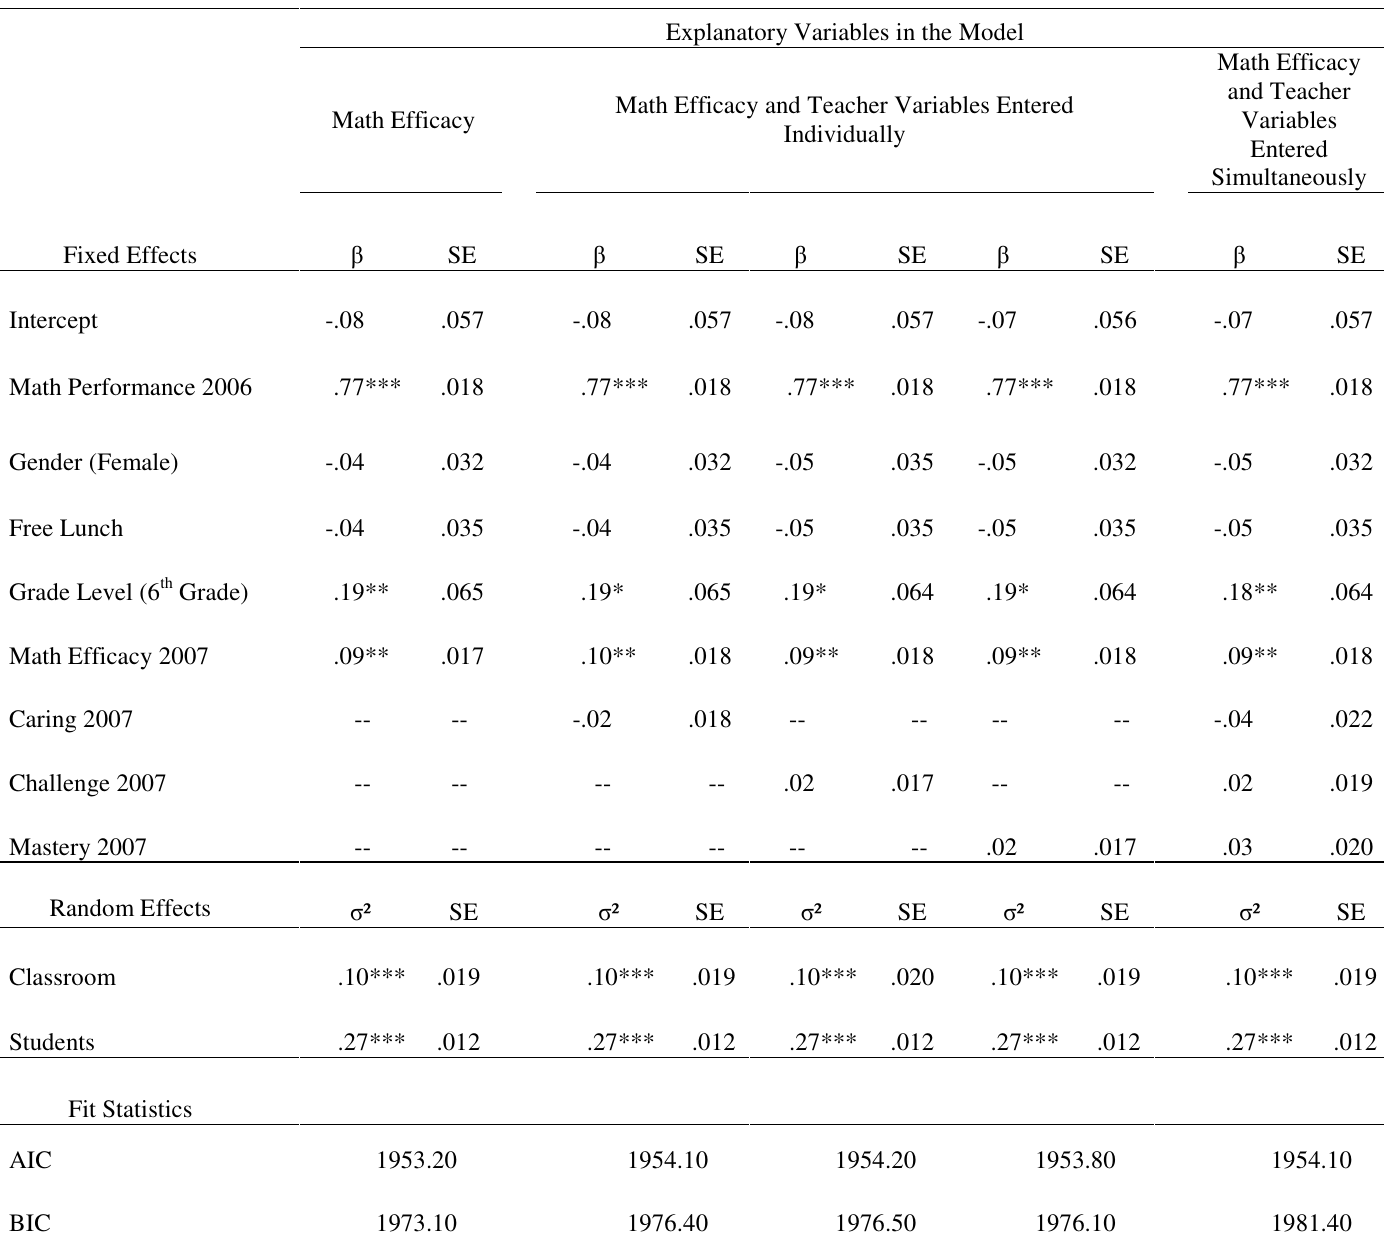
Math Performance 2007 Regressed on Math Efficacy and Teacher